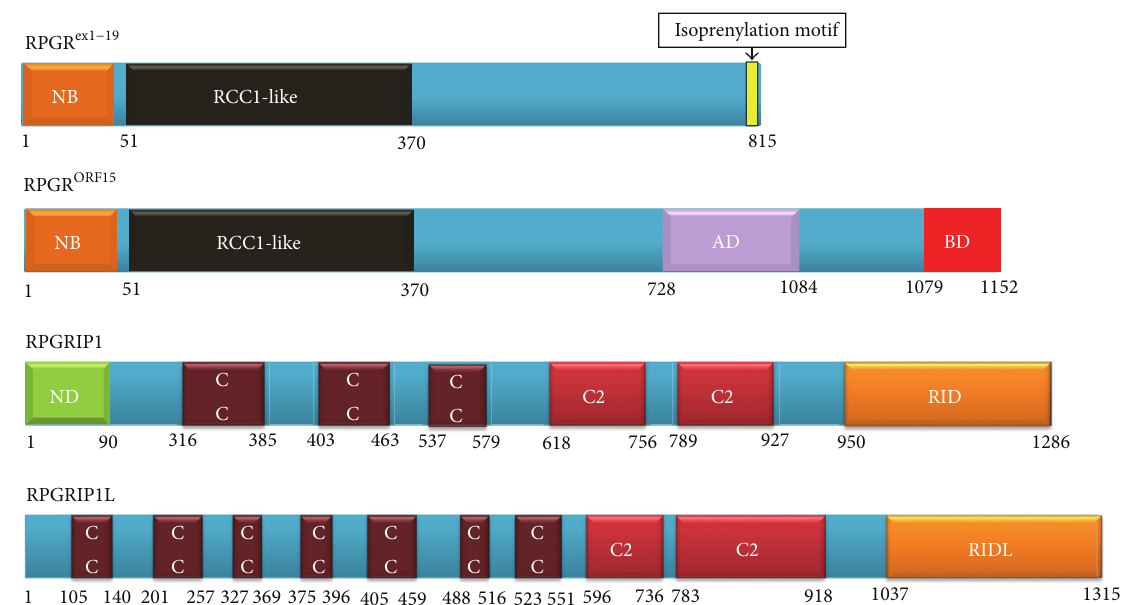
Figure 3: Structures of RPGR and its interacting proteins: RPGRIP1 and RPGRIP1L. The protein sequences of RPGR ex 1 – 19